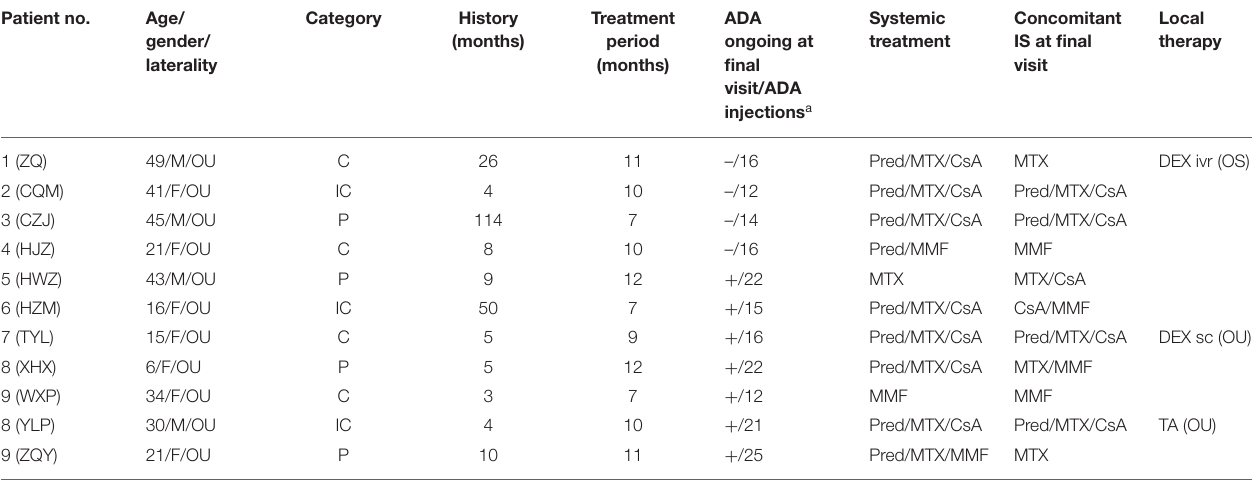
TABLE 1 | Demographics and concomitant treatments of 11 refractory VKH patients. Patient